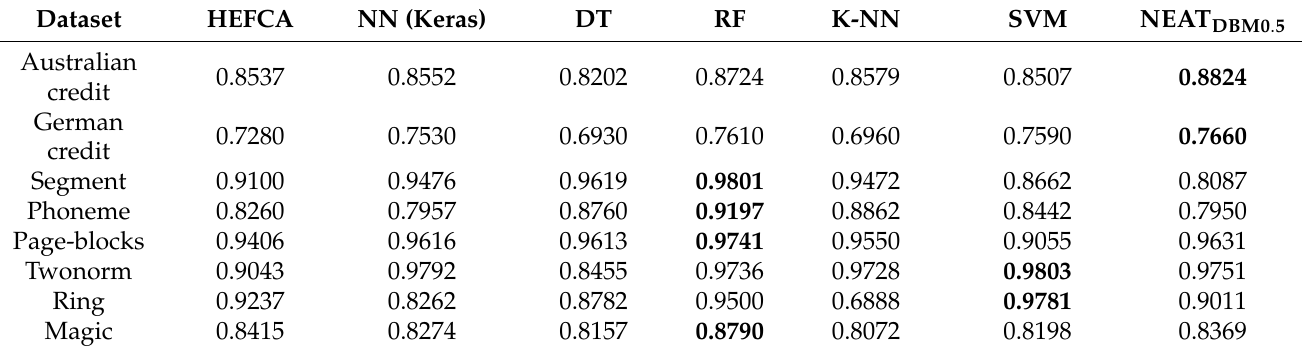
Table 7. NEAT compared to alternative approaches, test set.